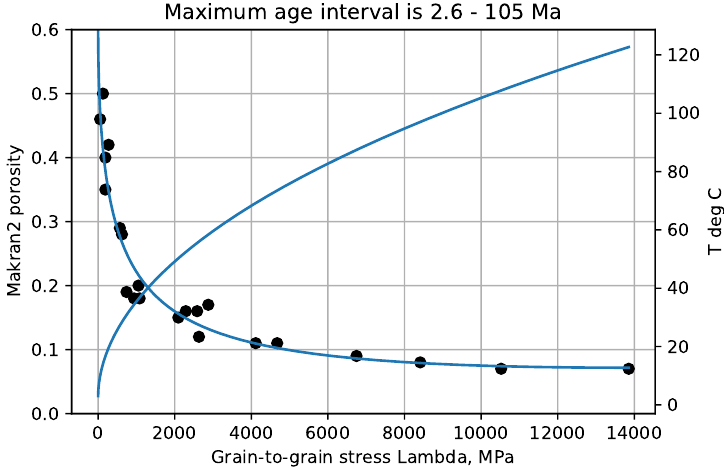
Figure 9. Makran2 porosity trend. Maximum age interval is 0.0 - 23 Ma.